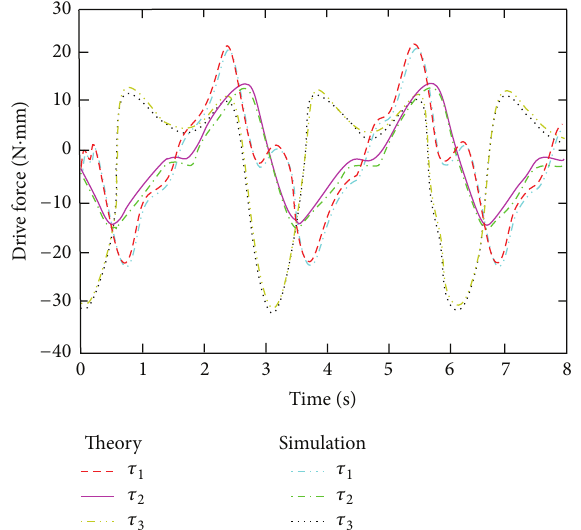
Figure 4: Driving force curve of servomotor.